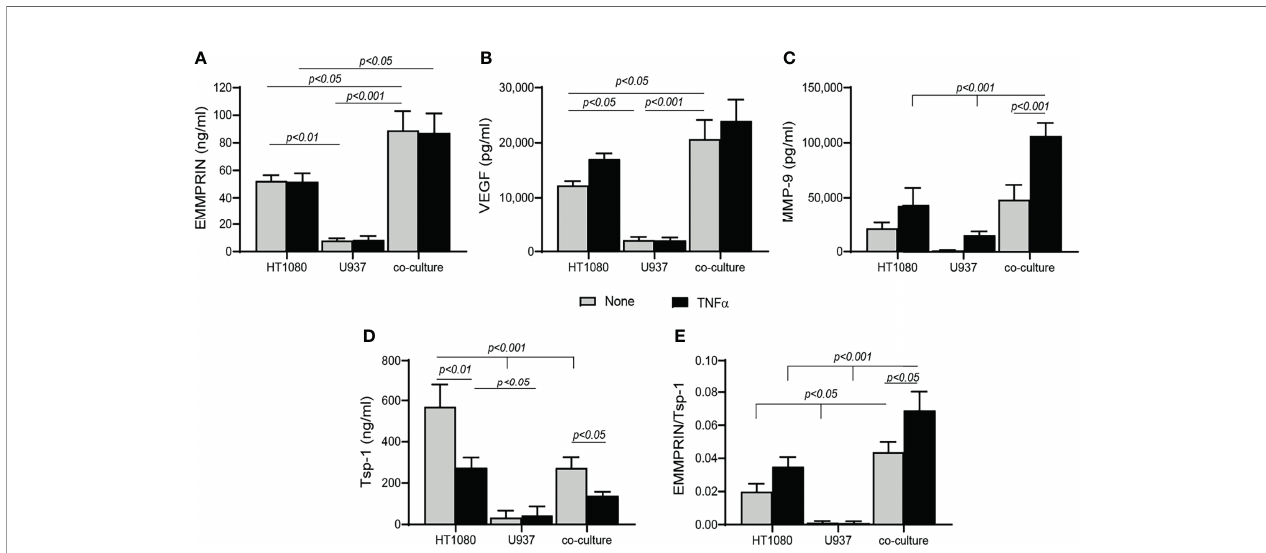
FIGURE 4 | Co-culture enhances angiogenesis. HT1080 cells (4x10 5 cells/well in 800 m L) were cultured alone or in co-culture with U937 monocytes at a ratio of 1:1, in the absence or presence of TNF a (1ng/mL). Supernatants were collected after 48h of incubation and the concentrations of (A) EMMPRIN, (B) VEGF, (C) MMP-9, and (D) Tsp-1 were determined by ELISA. (E) The EMMPRIN/Tsp-1 ratio was calculated for each repetition. The two-way analysis of variance (ANOVA) test was used to compare multiple groups, followed by the post-hoc Bonferroni ’ s multiple comparison test (n=6-7 in all